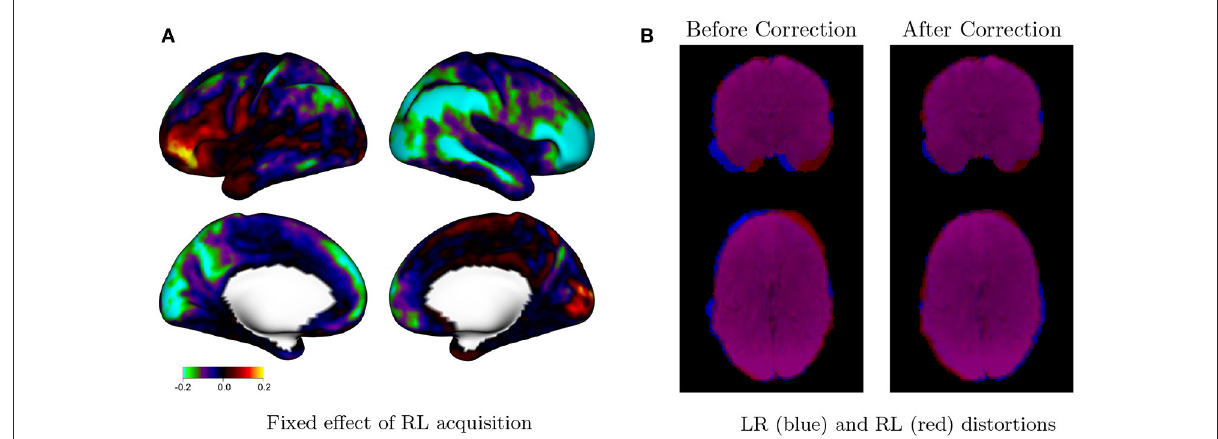
FIGURE6 Effect of phase encoding direction on autocorrelation. (A) Fixed effect of RL phase encoding direction in model (2). Values represent the differences in average autocorrelation index (ACI) at each vertex when the RL (vs. LR) phase encoding direction is used during image acquisition. Cool colors on the right lateral cortex, for example, indicate that RL acquisitions tend to have reduced autocorrelation in those areas compared with LR acquisitions. The effect of phase encoding direction is clearly lateralized, with the RL acquisition resulting in relatively lower autocorrelation on the right side of each hemisphere and higher autocorrelation on the left side of each hemisphere. This is likely due to distortions induced by the RL and LR phase encoding directions, even after distortion correction. (B) Mean rest fMRI image for a single subject (103,818) for LR (blue) and RL (red) runs during the same session, before and after distortion correction, shown in neurological convention. Lateralized distortions persist after distortion correction, based on the imperfect overlap between the LR and RL runs.